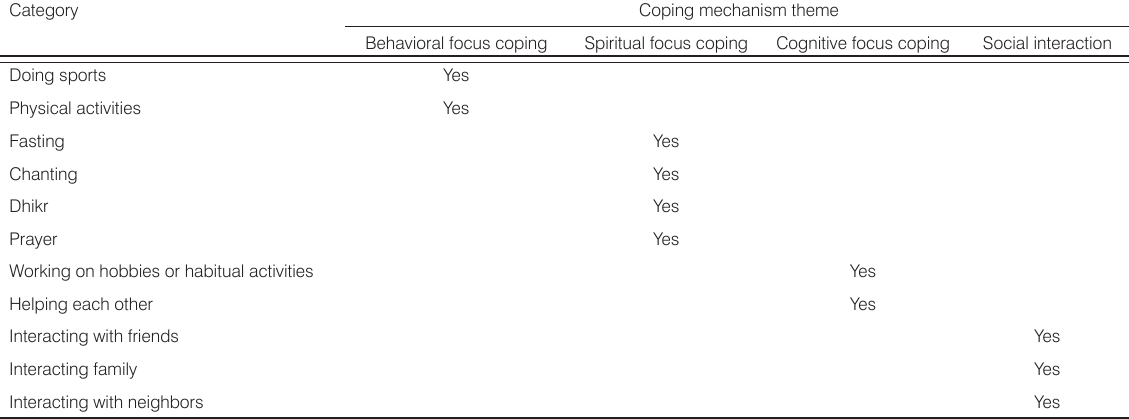
Table 2. Summary of unit/codes, category, and